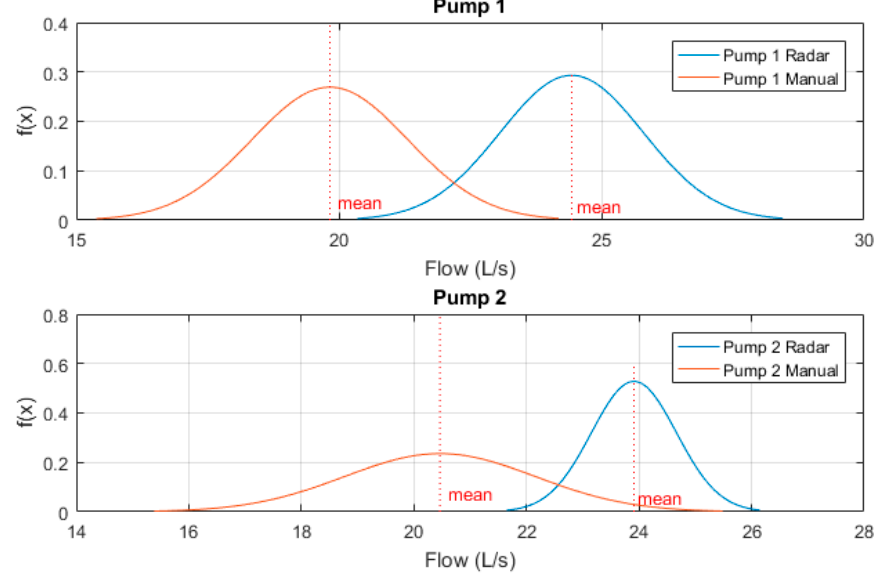
Figure 12. Site A normalised radar vs manual testing results.